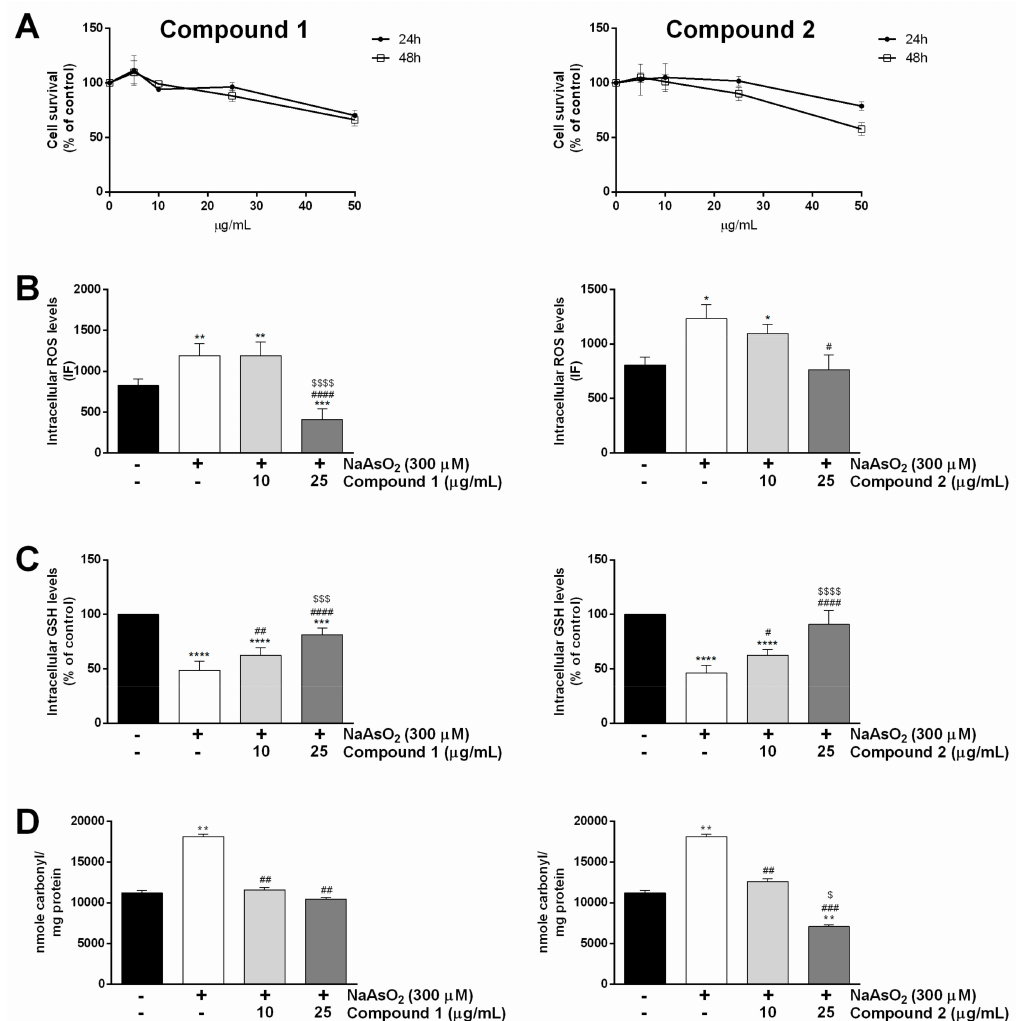
Figure 2. E ff ect of compounds 1 and 2 on human keratinocyte (HaCaT) cells. A : Dose–response curves of HaCaT cells after 24 h (black circles) and 48 h (empty squares) incubation in the presence of di ff erent concentrations of each compound. Cell survival rate was defined as in the Materials and Methods section. B – D : cells were pre-incubated in the presence of pure compounds (10 and 25 µ g / mL) for 2 h and then exposed to 300 µ M NaAsO 2 for 60 min. B : intracellular reactive oxygen species (ROS) levels; C : intracellular glutathione (GSH) levels; D : protein carbonylation levels. Black bars refer to untreated cells, white bars to NaAsO 2 -treated cells, light grey bars to 10 µ g / mL-treated cells and dark grey bars to 25 µ g / mL-treated cells. Results are expressed as the means ± S.D. of three independent experiments, each carried out in triplicate. * indicates p < 0.05, ** indicates p < 0.01, *** indicates p < 0.001, **** indicates p < 0.0001, with respect to control cells; # indicates p < 0.05, ## indicates p < 0.01, ### indicates p < 0.001, #### indicates p < 0.0001, with respect to NaAsO $ indicates 2 -treated cells; p < 0.05; $$$ indicates p < 0.001, $$$$ indicates p < 0.0001 with respect to 10 µ g / mL-treated